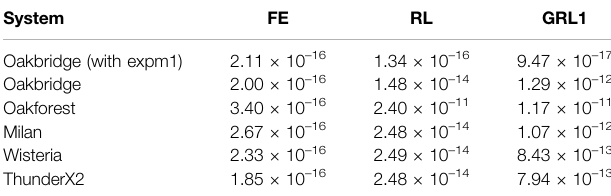
TABLE 9 | RRMS error when solving the TP06 model using SIMD and vectorised math functions. For each ODE solver scheme a reference solution is computed on Milan using scalar math functions and with compiler optimisations disabled. The model is solved for 1 s with a time step Δ t = 1